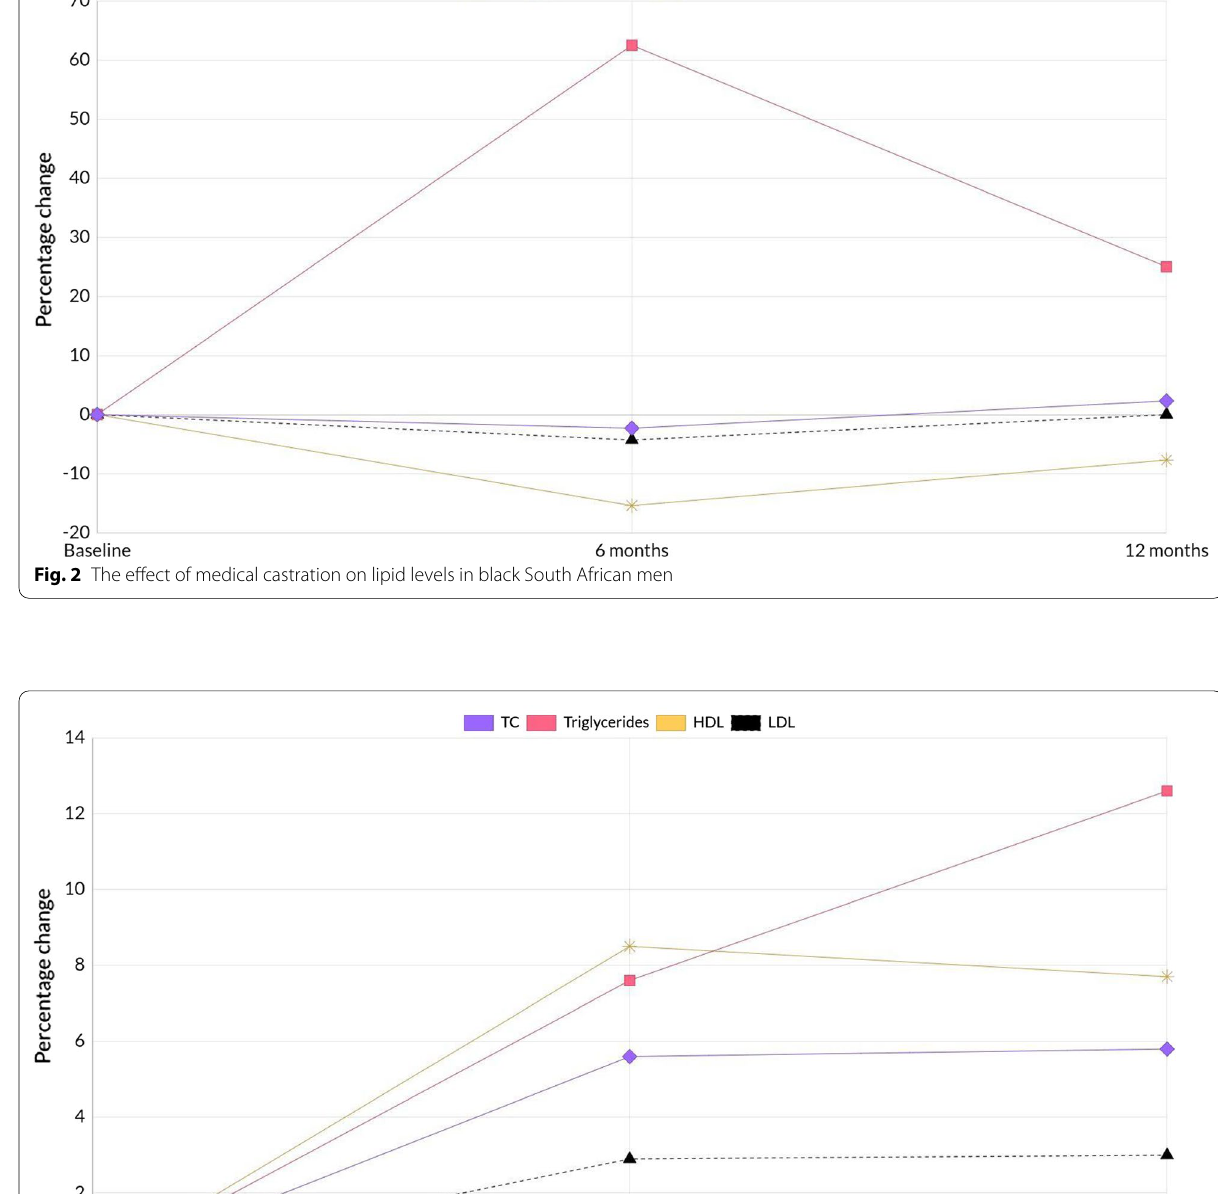
lipid parameters were significantly increased at both 6 months and 12 months with TG levels showing the greatest percentage change [57]. Their results are shown in Fig. 3.